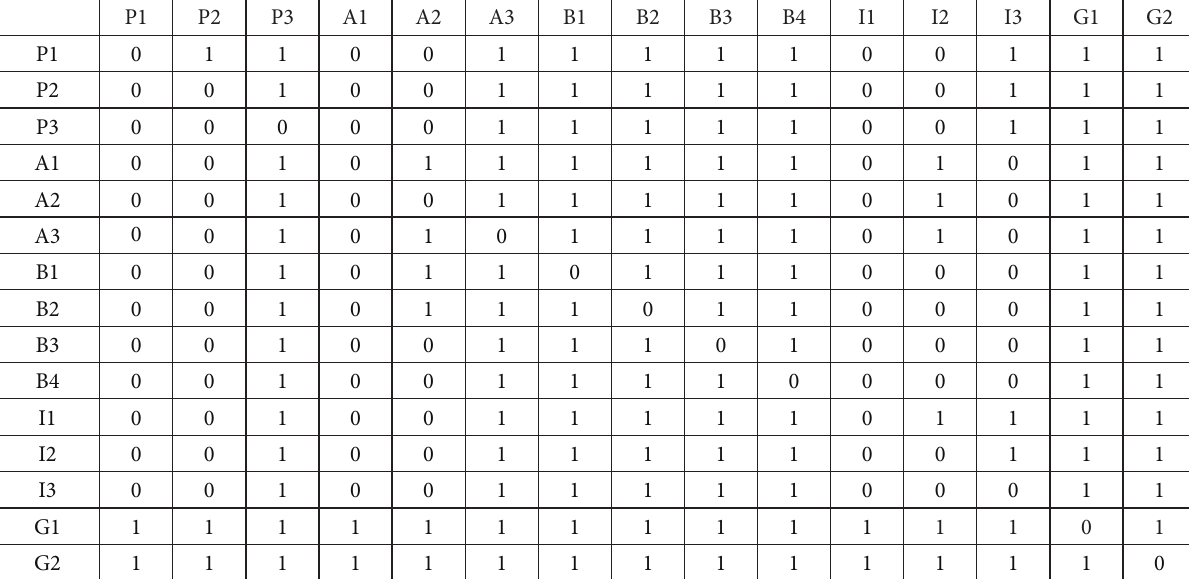
Table 3. Relationship matrix of all elements of the